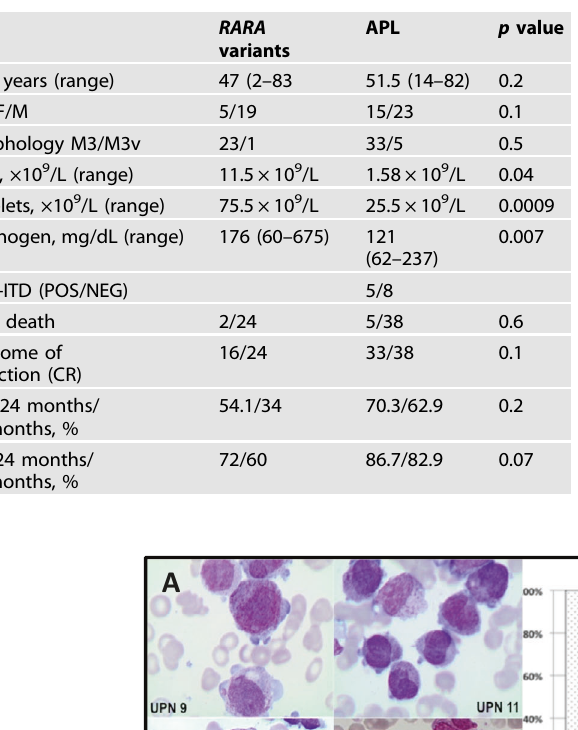
Table 1. Comparison of clinico-biological characteristics at diagnosis of RARA variants and PML-RARA-positive APL.